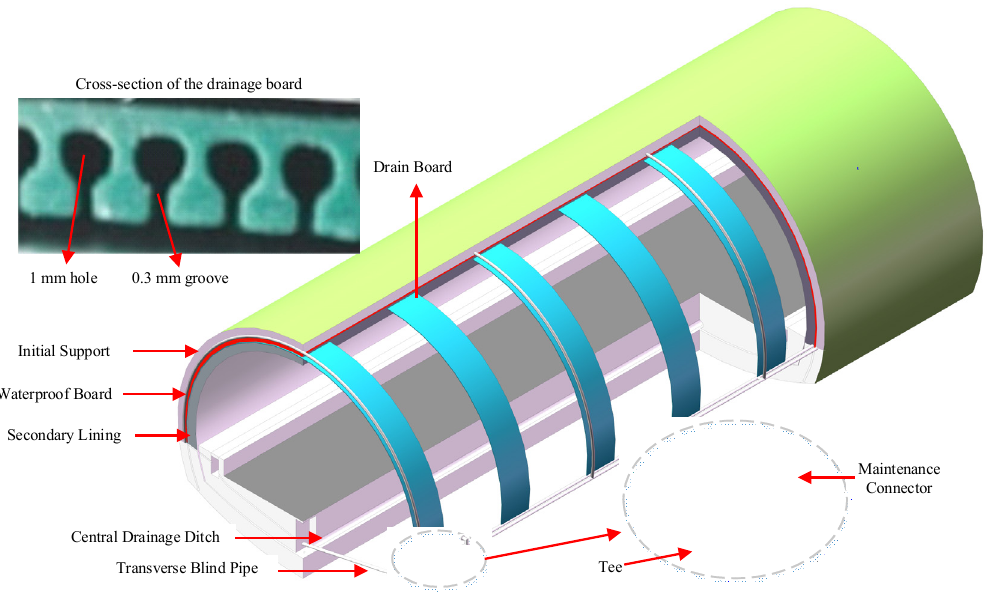
Figure 3. Proposed composite waterproof and drainage system.